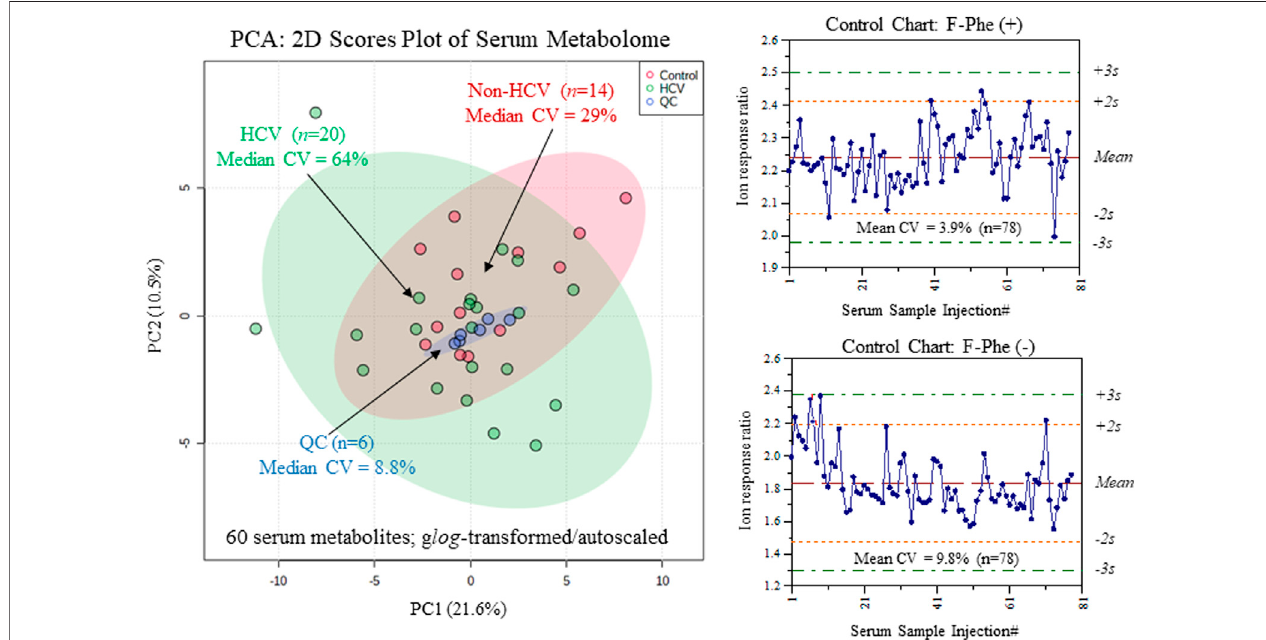
FIGURE 2 | Overview of the serum metabolome and data quality when using MSI-CE-MS as depicted in 2D scores plot using PCA, which compares the technical precision(medianCV (cid:1) 8.8%, n (cid:1) 6)fromrepeatQCsamplesrelativetothelargerbiologicalvarianceinchronicHCVliver fi brosispatients(medianCV (cid:1) 64%, n (cid:1) 20)and non-HCV controls(medianCV (cid:1) 29%, n (cid:1) 14).Controlchartsfortherecoverystandard(3- fl uorophenylalanine,F-Phe)con fi rmsacceptableintermediateprecision(mean CV (cid:1) 6.8%, n (cid:1) 156) when analyzing all serum samples in this study by MSI-CE-MS in positive and negative ion